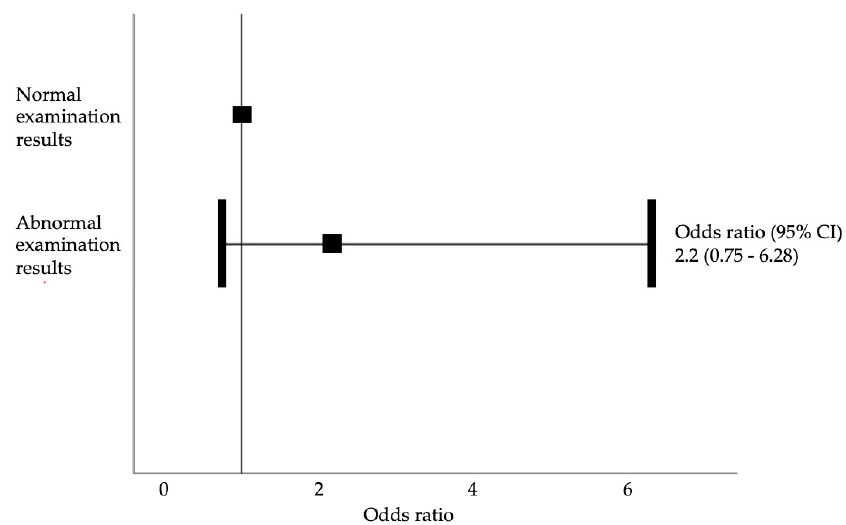
Figure 5. Odds ratio of abnormal neuroimaging results in neurological examination ( p = 0.15), representing the likelihood of neuroimaging changes in relation to the normal/abnormal neurological examination.